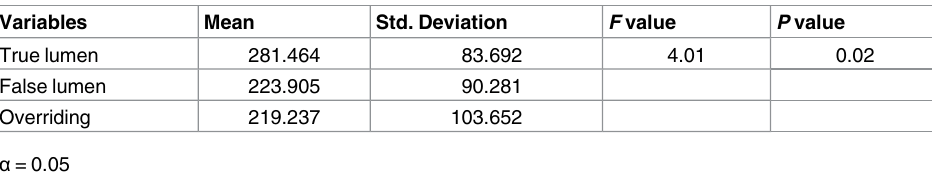
Table 3. One-way